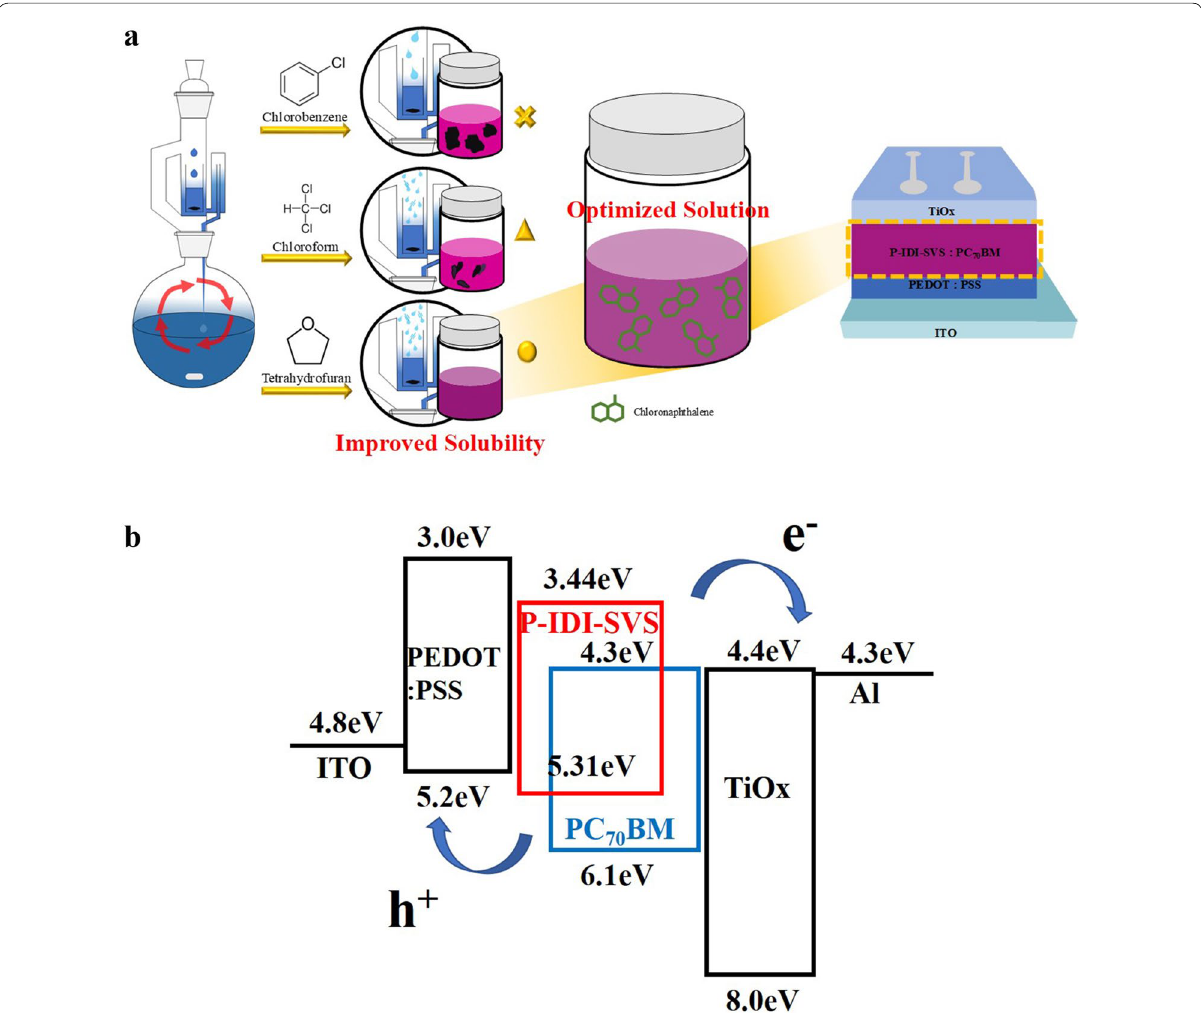
Fig. 1 a Image of solubility change due to Soxhlet solvent and device structure of P‑IDI‑SVS:PC 70 BM BHJ solar cell. b Energy level diagram of the organic solar